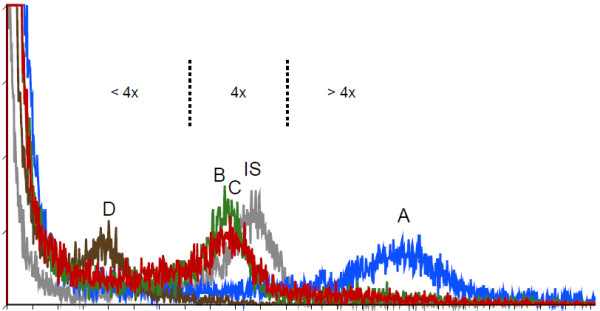
 Diagrams showing the result of flow cytometric determination of DNA ploidy levels of selected specimens. A tetraploid sample belonging to the Lepisorus clathratus complex was used as the internal standard (IS, grey graph). X-axis shows the relative fluorescence, Y-axis the number of nuclei. (A)Platygyria specimen 28 with cpDNA belonging to Nyingchi Platygyria (blue graph). (B)Platygyria specimen 101with cpDNA belonging to G3 (green graph), (C)Platygyria specimen 38 with cpDNA belonging to G4 (red graph). (D)Platygyria specimen 119 with cpDNA belonging to G5 (brown graph). Dashed lines indicate the divide of the genome size interpretation: 4x, <4x, and >4x based on the IS = 4x.